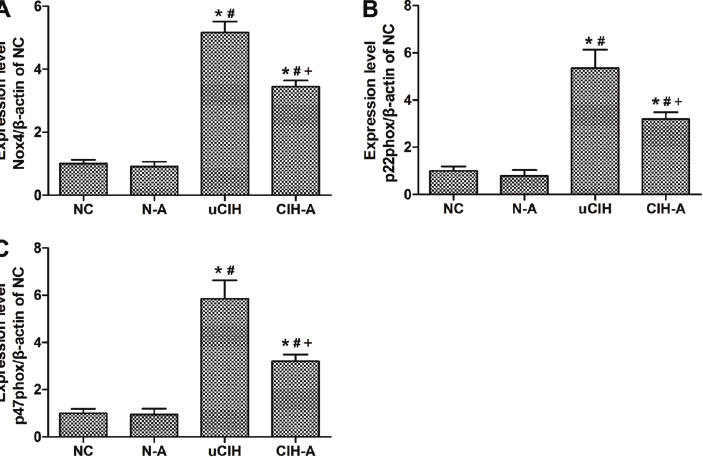
Figure 6. Gene expression of Nox4, p22phox and p47phox analyzed by real-time PCR. Ampli fi cation of b -actin served as a control, and the levels were compared with normoxia control (NC) lungs taken as 100% (n=8). N-A: NC and Ang-(1 – 7) supple- mented group; uCIH: untreated chronic intermittent hypoxia group; CIH-A: CIH and Ang-(1 – 7) supple- mented group. *P o 0.05 vs NC; # P o 0.05 vs N-A; + P o 0.05 vs uCIH